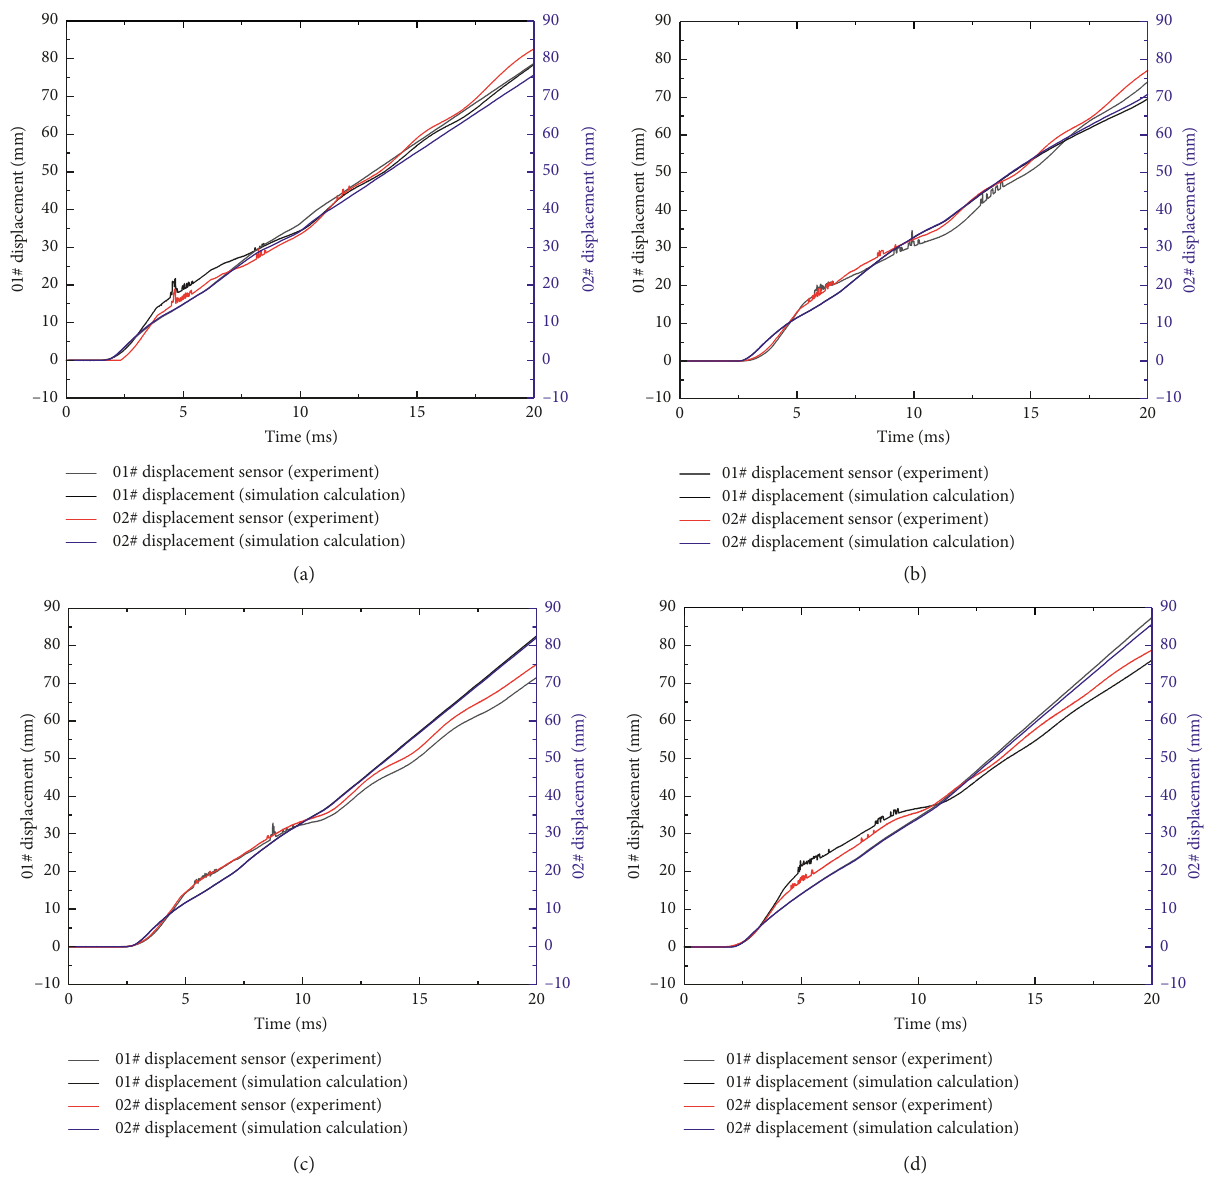
Figure 18: The comparison of the slotted displacements. (a) T-1, (b) T-2, (c) T-3, and (d)